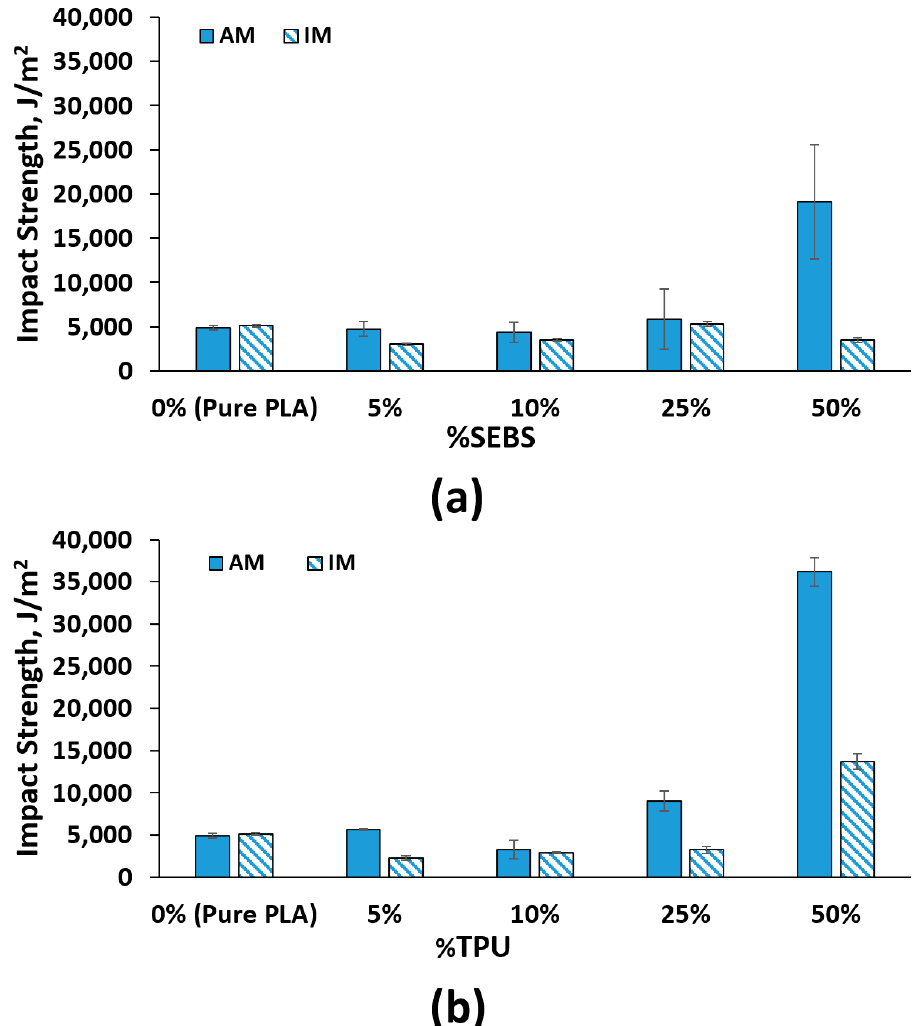
Figure 9. Impact strength values for ( a ) the PLA:TPU system and ( b ) the PLA:SEBS system where AM corresponds to additively manufactured specimens and IM corresponds to injection molded specimens.